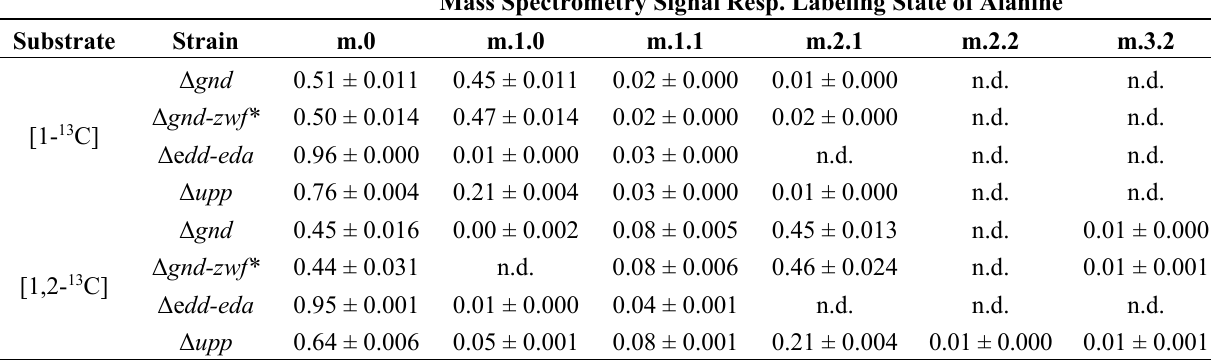
Table 2. Fragmentation pattern of alanine for (1- 13 C)- and (1,2- 13 C)-labeled glucose. The nomenclature of the 13 C labeling states of the metabolites is presented in Section